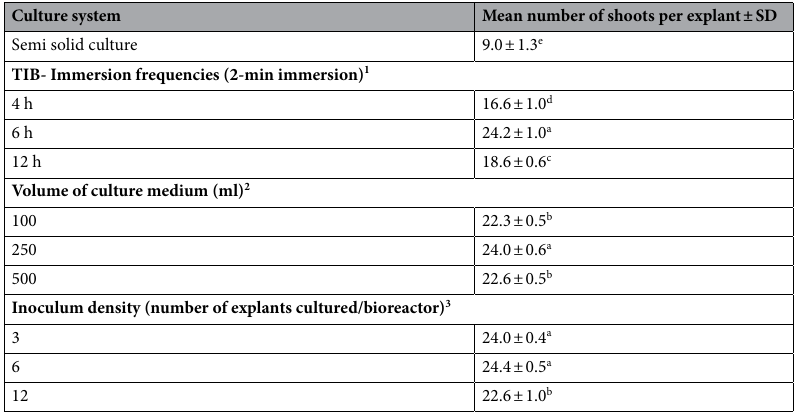
Table 1. Effect of the culture systems on immersion frequency, volume of culture medium and inoculum density on multiplication shoots per explant. Results were recorded after 21 days of culture duration. Numbers represent the mean ± SD (standard deviation). Means with different letter are significantly different (DMRT, p ≤ 0.05). 1 Experiment carried out with 250 ml of culture medium and 6 numbers of inoculum used. 2 Experiment carried out with 2-min immersion for every 6 h and 6 numbers of inoculum used. 3 Experiment carried out with 250 ml of culture medium and 2-min immersion for every 6 h. Data shown in the table are recorded during the 3rd subculture of the